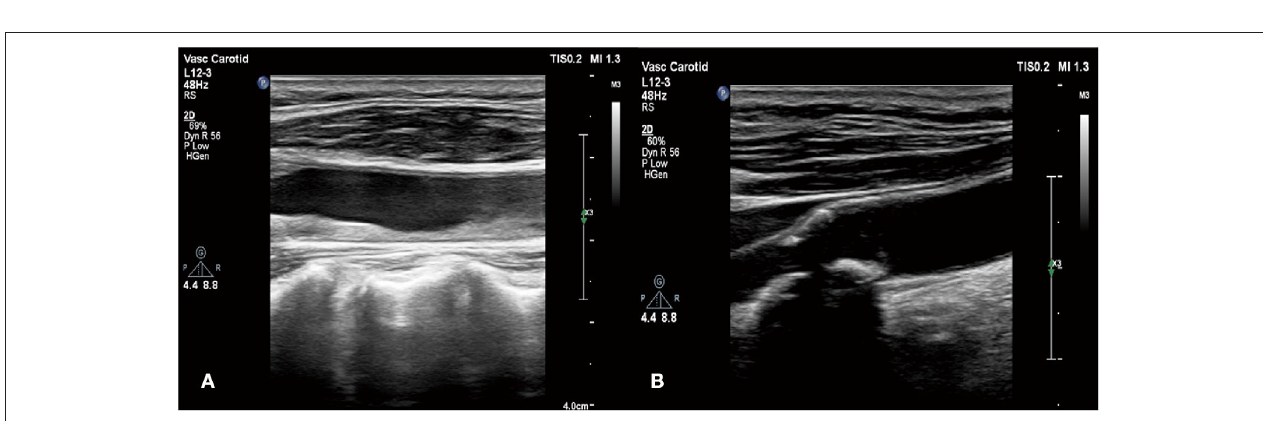
FIGURE 4 | (A) Stenosis in the initial segment of left internal carotid artery and left external carotid artery; (B) stenosis in the right external carotid